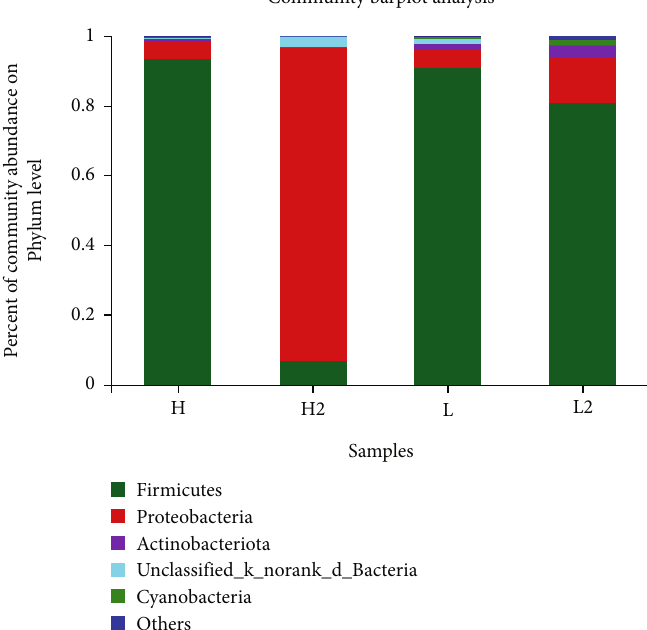
Figure 2: Intestinal microbiota community abundance of rainbow trout at phylum level. H:, High fi shmeal group; H2:, High fi shmeal + 2.0 g/kg NaB; L:, Low fi shmeal group; L2:, Low fi shmeal + 2.0 g/kg